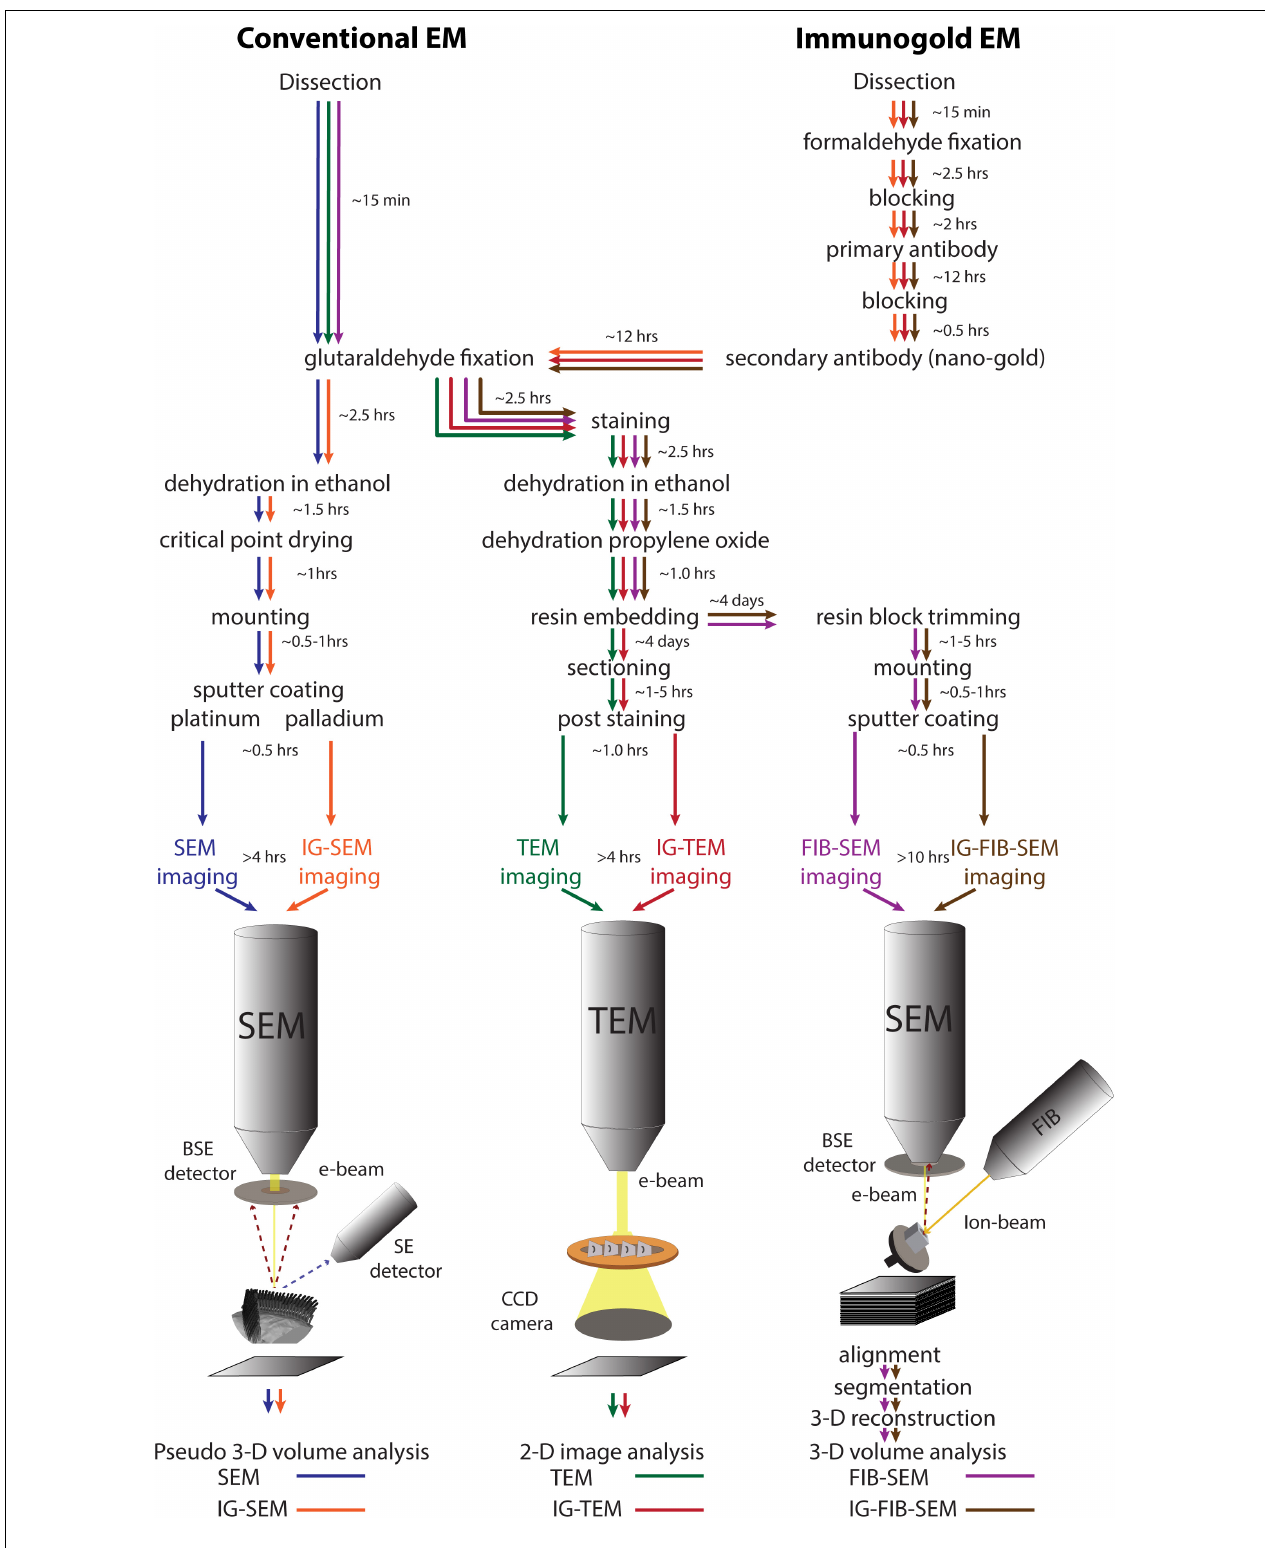
FIGURE 1 | A schematic diagram of the work flow for different electron microscopic approaches: conventional SEM (blue), conventional TEM (green), FIB-SEM (magenta), IG-SEM (orange), IG-TEM (red), IG-FIB-SEM (brown). The time ranges refer to the protocols used in this study. SE, secondary electrons; BSE, backscattered